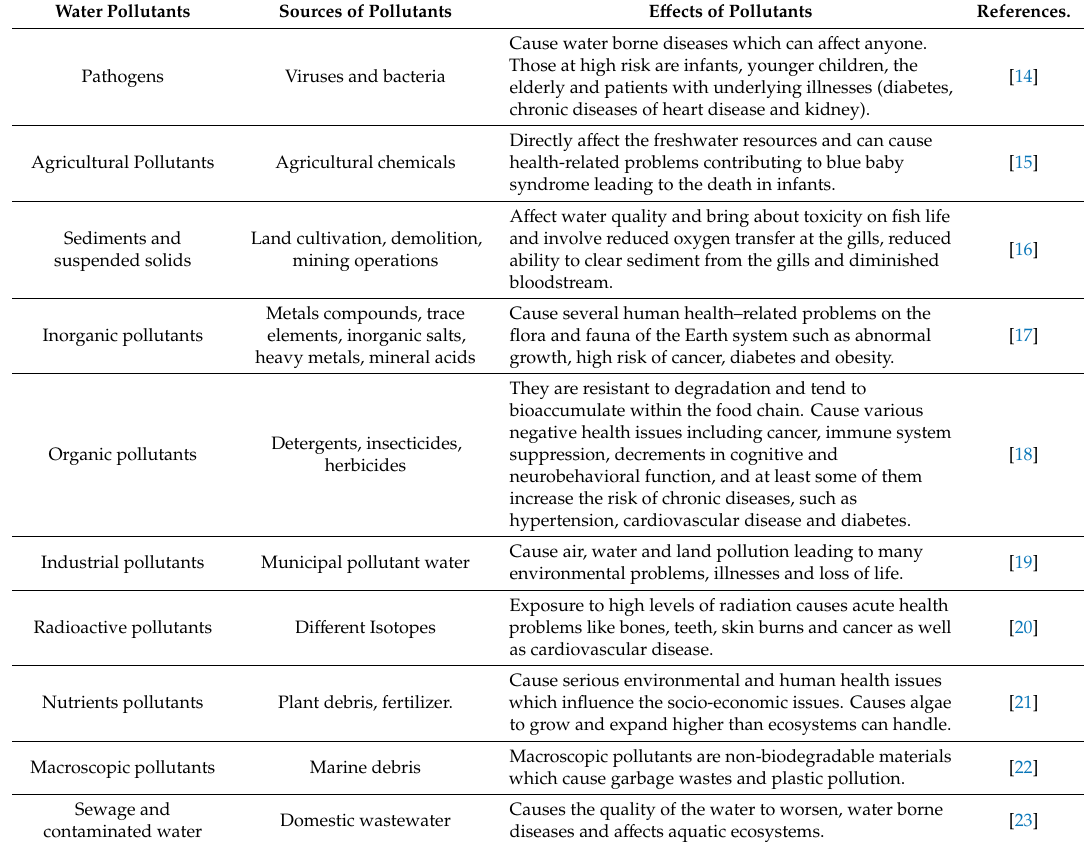
Table 1. List of di ff erent water pollutants with their sources and adverse e ff ects. Water